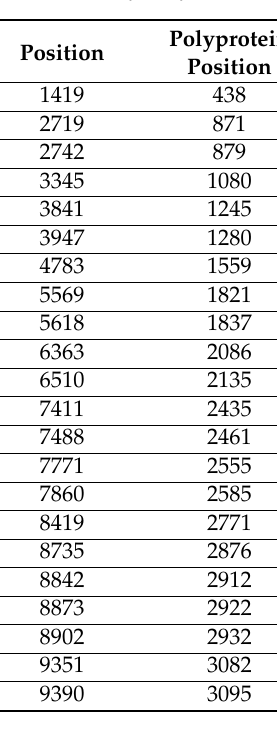
Table 2. Non-synonymous SNVs among the 2016 Brazilian ZIKV